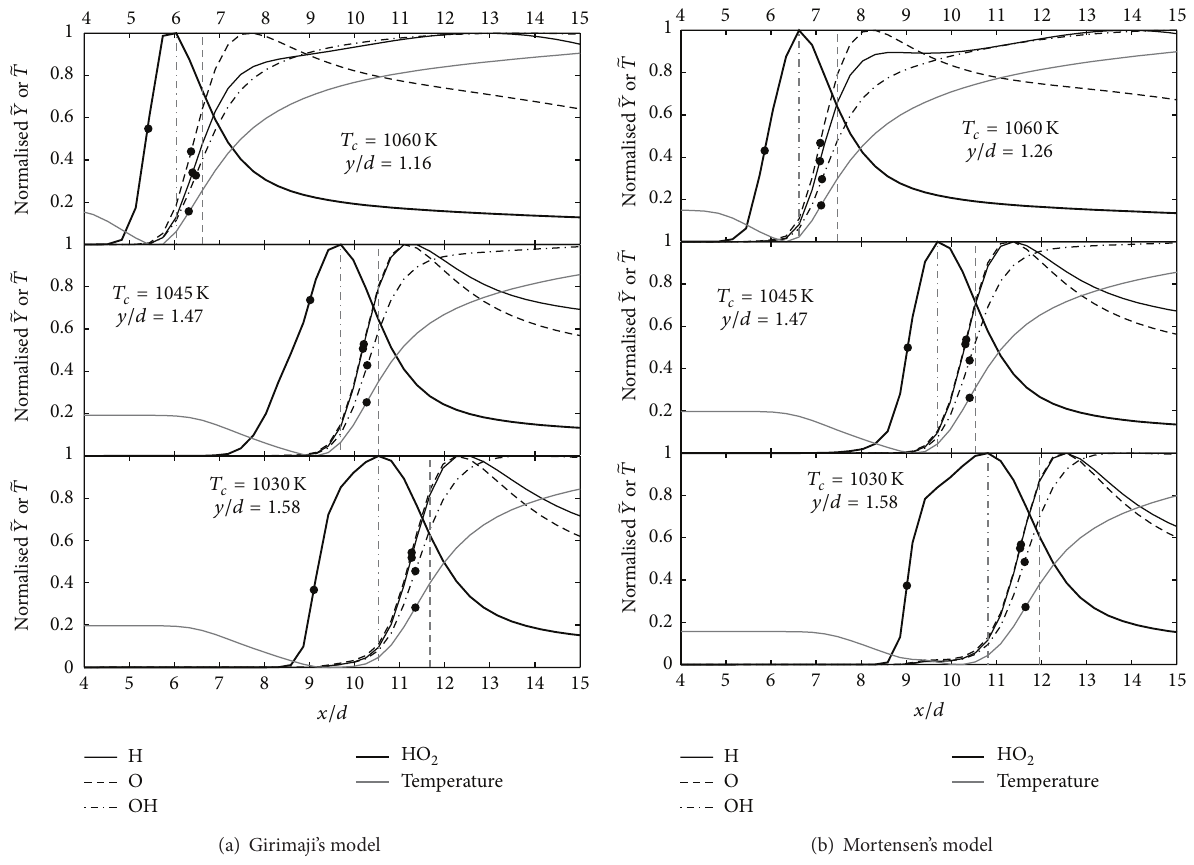
Figure 8: Axial profiles of the normalised Favre-averaged temperature and mass fractions of H, O, OH, and HO 2 obtained at the radial locations of stabilisation corresponding to each 𝑇 𝑐 : (a) Girimaji’s model and (b) Mortensen’s model. The vertical dash-dotted and dashed lines correspond to the axial locations of maximum HO 2 and liftoff height, respectively. The circles indicate the locations of the maximum